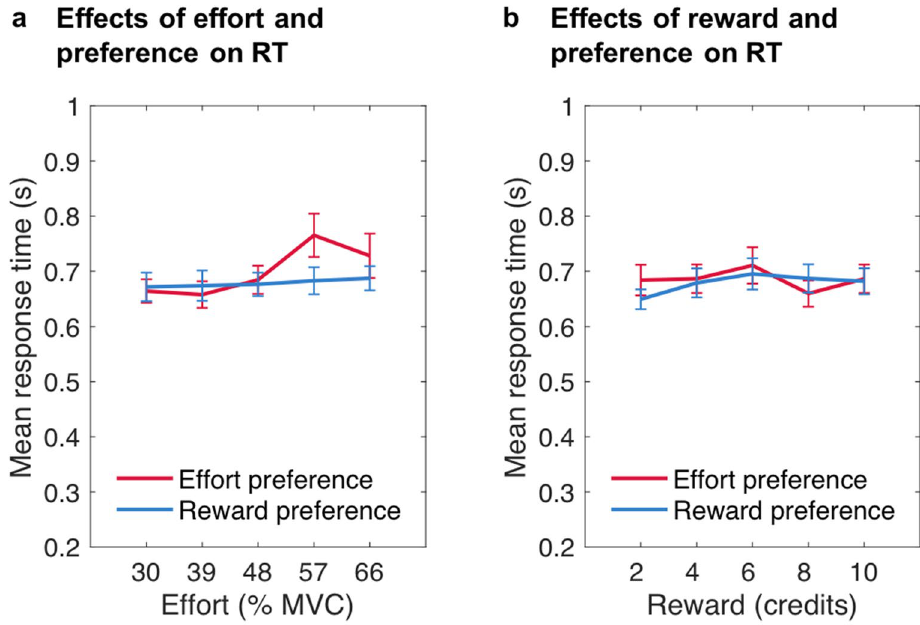
Figure 5. Response times for accepted offers dependent on participants’ preferences on a trial. Mean response times (RTs) in seconds dependent on ( a ) the effort level and ( b ) the reward level of the work offer, as a function of preference on a given trial. Reward preference depicts response times on trials on which participants chose to first see reward information, while effort preference depicts response times on trials on which participants chose to first see effort information. Error bars represent standard errors of the